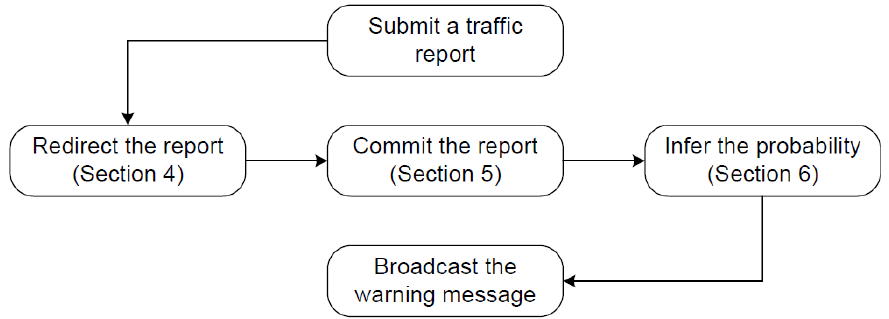
Figure 2. Work flow of